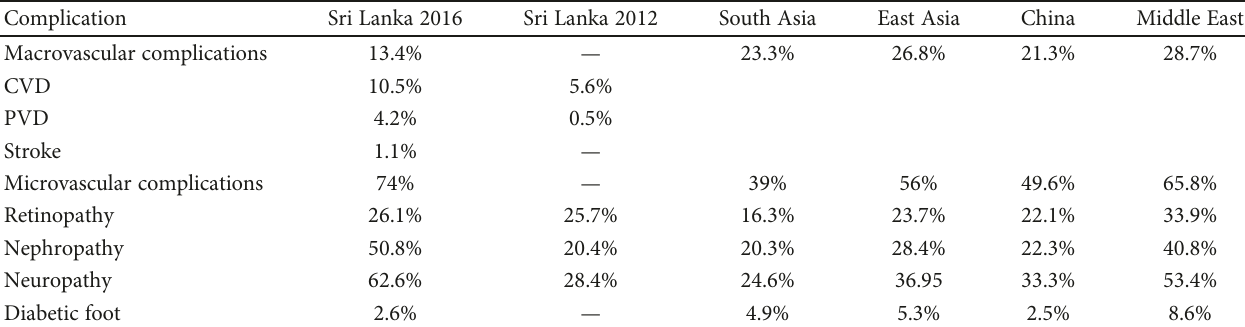
Data from other regions taken from a multinational study done from 2009-2010